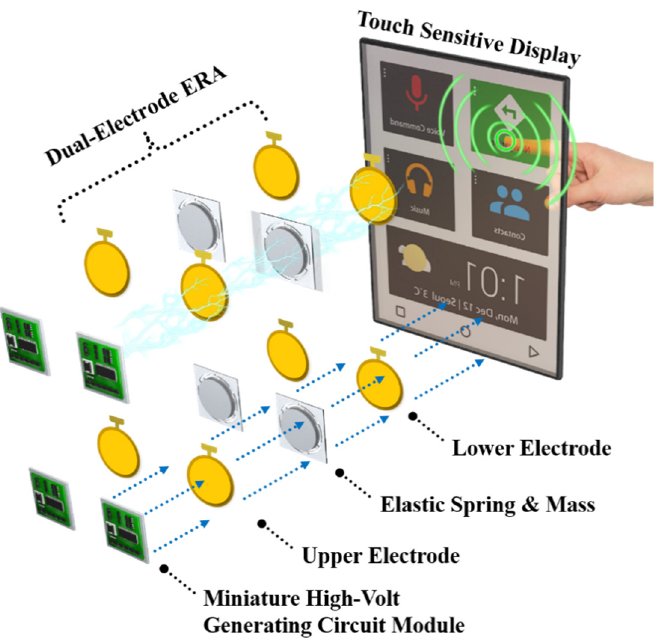
Figure 11. An illustration of dual-electrode ERA modules for a touch-sensitive display.